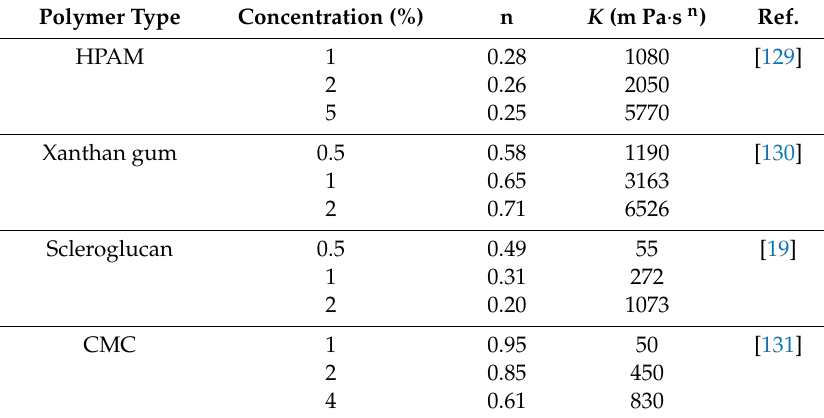
Table 7. Rheology parameters of biopolymers and